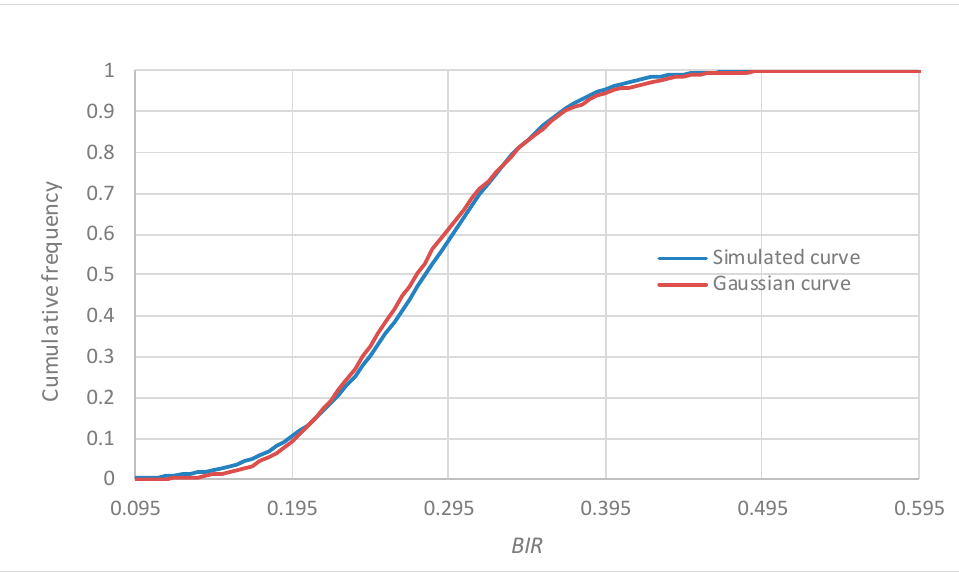
Figure 1. Comparison between simulated and analytical relative frequency curves.